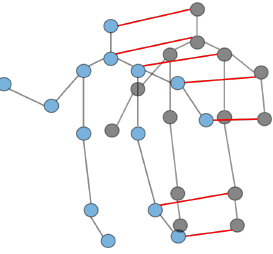
Figure 1. IE-Graph Representation: The joint edge (black) links the joints within the same subject, and the subject edge (red) links the joints of the same kind between different subjects, which models the interactive information. For brevity, we show only a portion of the subject edges in the